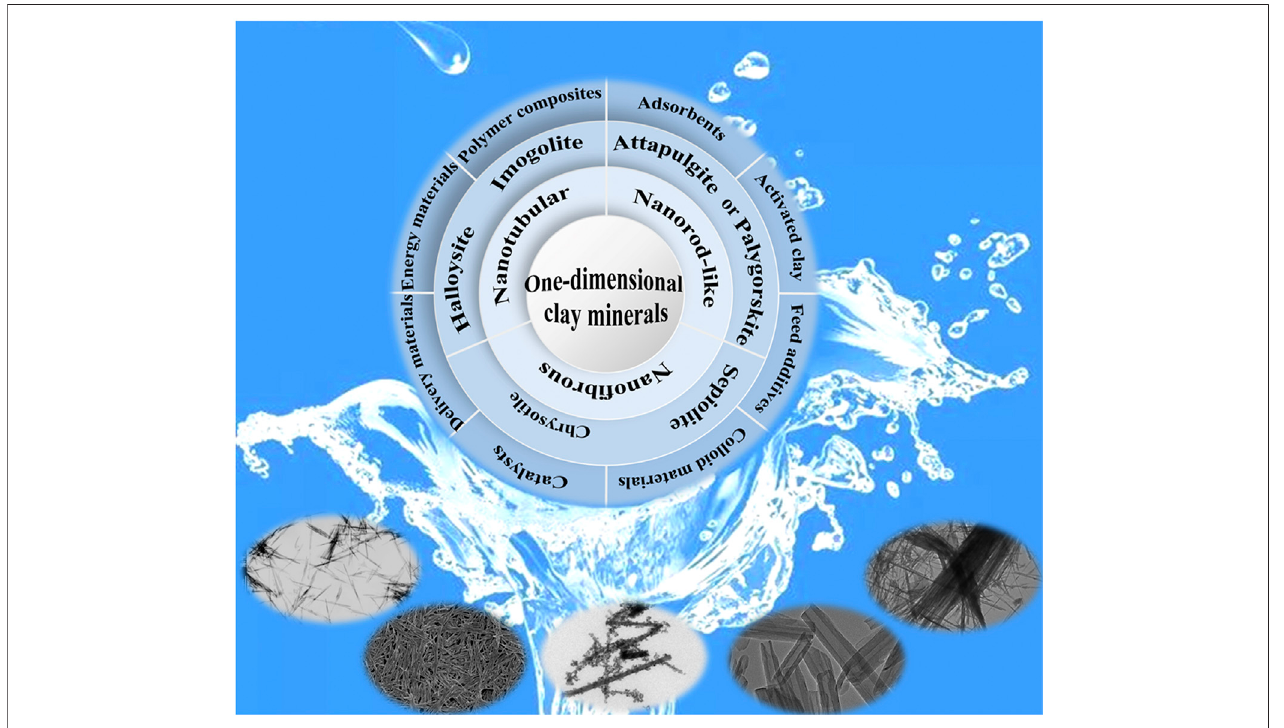
FIGURE 1 | Advanced functional derived from one-dimensional clay